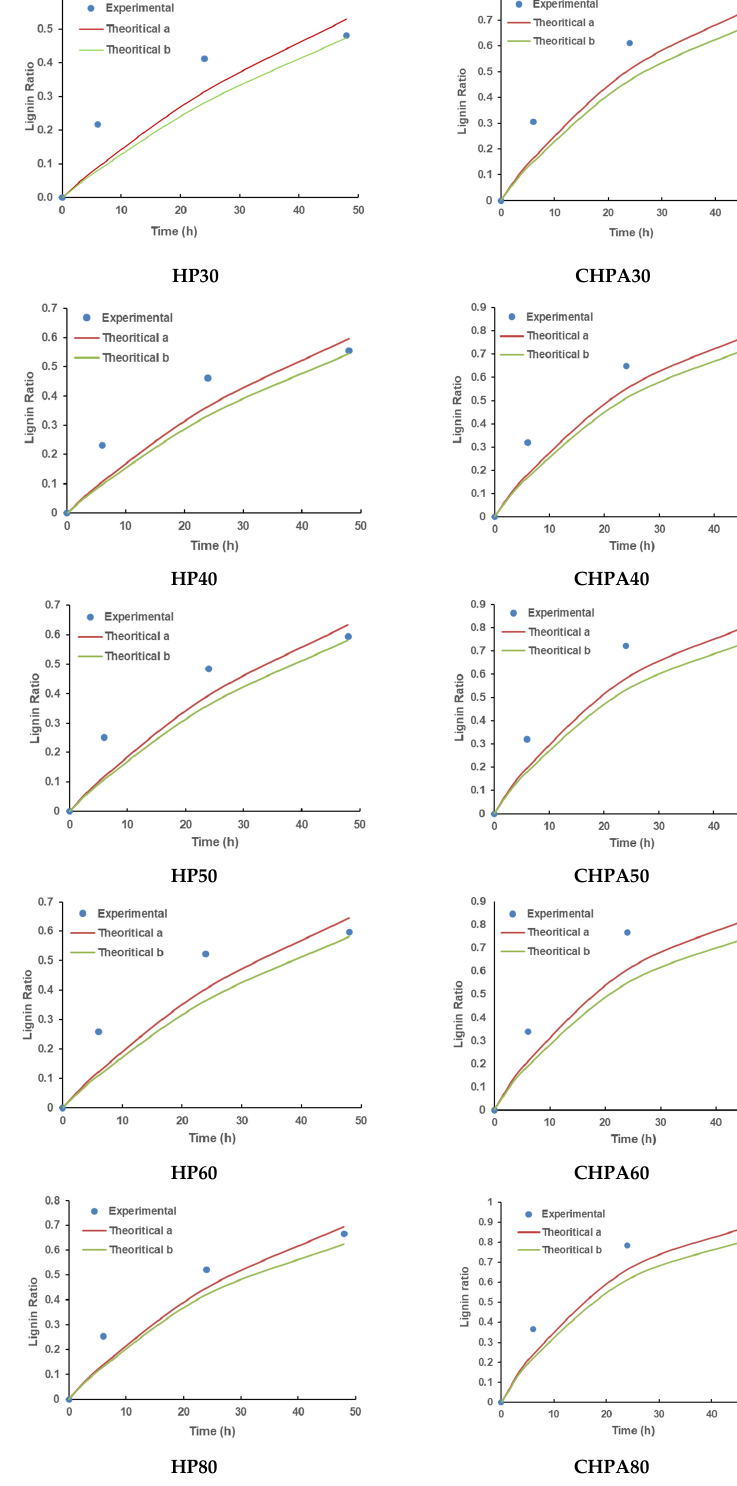
Figure 4. Validation of kinetics models of rice husk pretreatment using experimental data; theoretical (a) depicts experimental data suited to Equation (2), while theoretical (b) shows the same adapted to Equation (4) including the degree of pretreatment (Dd). (HP30, HP40, HP50, HP60, and HP80 Hydrogen Peroxide Pretreatments at 30 °C, 40 °C, 50 °C, 60 °C, and 80 °C, respectively; CHPA30, CHPA40, CHPA50, CHPA60, and CHPA80 Combination Hydrogen Peroxide–Aqueous Ammonia Pretreatments at 30 °C, 40 °C, 50 °C, 60 °C, and 80 °C, respectively).